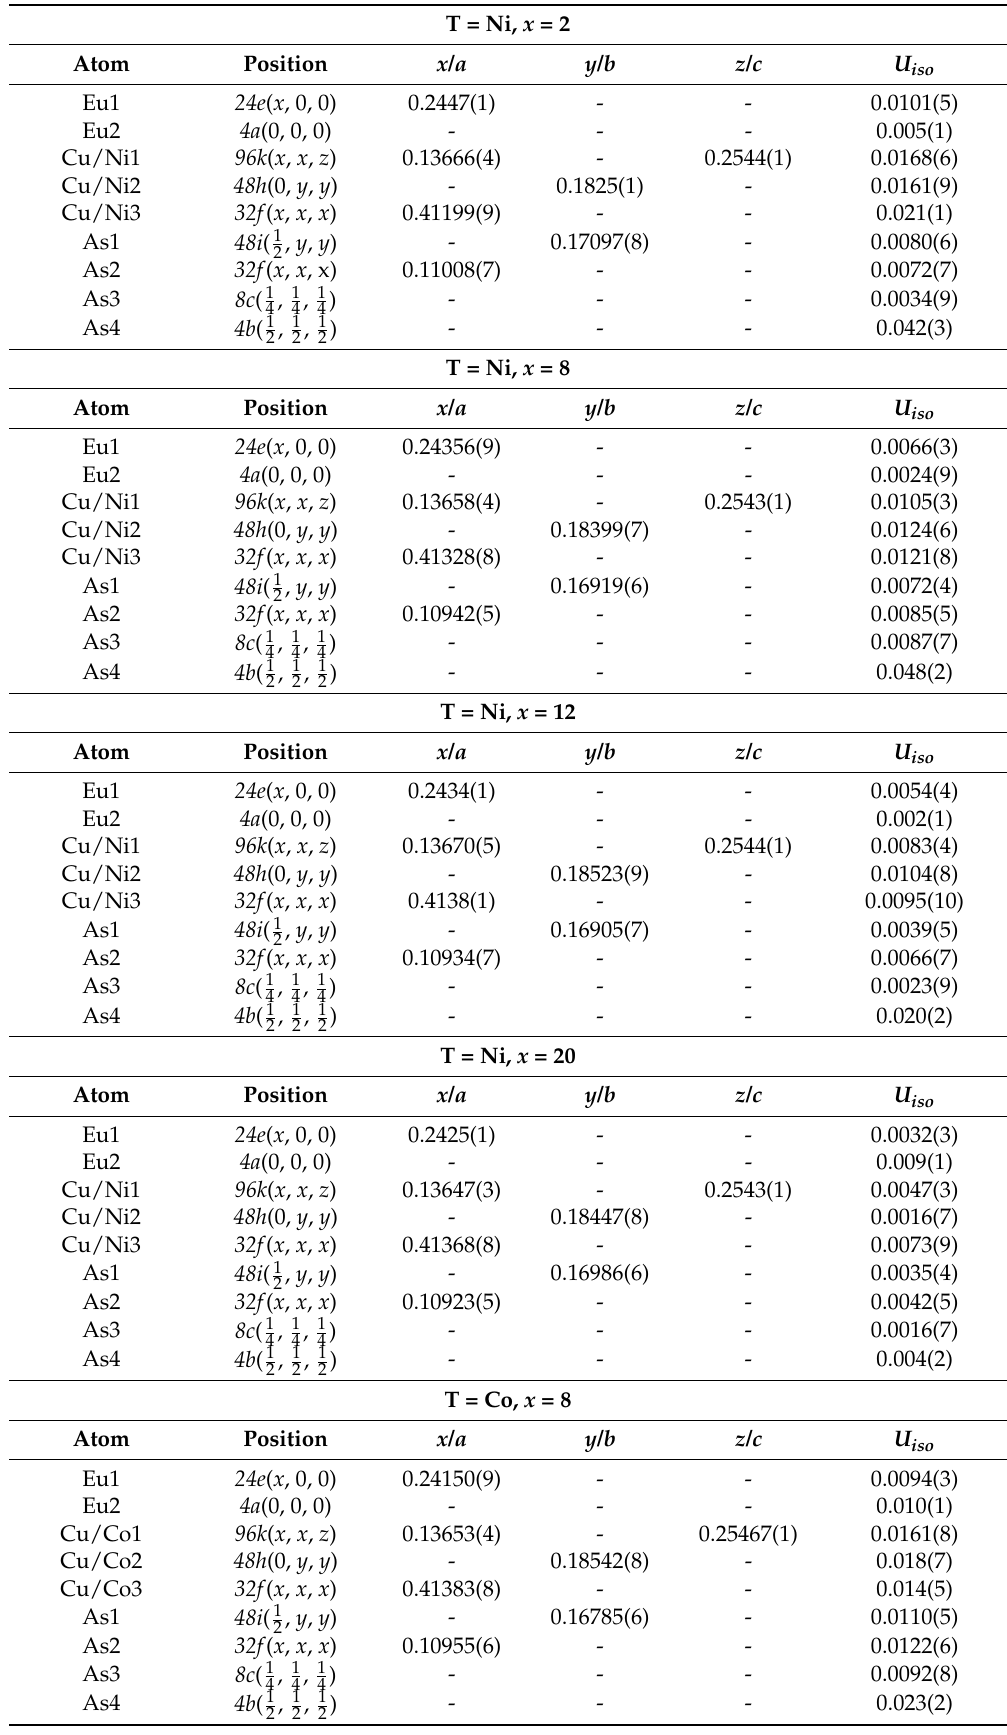
Table 2. Refined atomic parameters for Eu 7 Cu 44 ´ x T x As 23